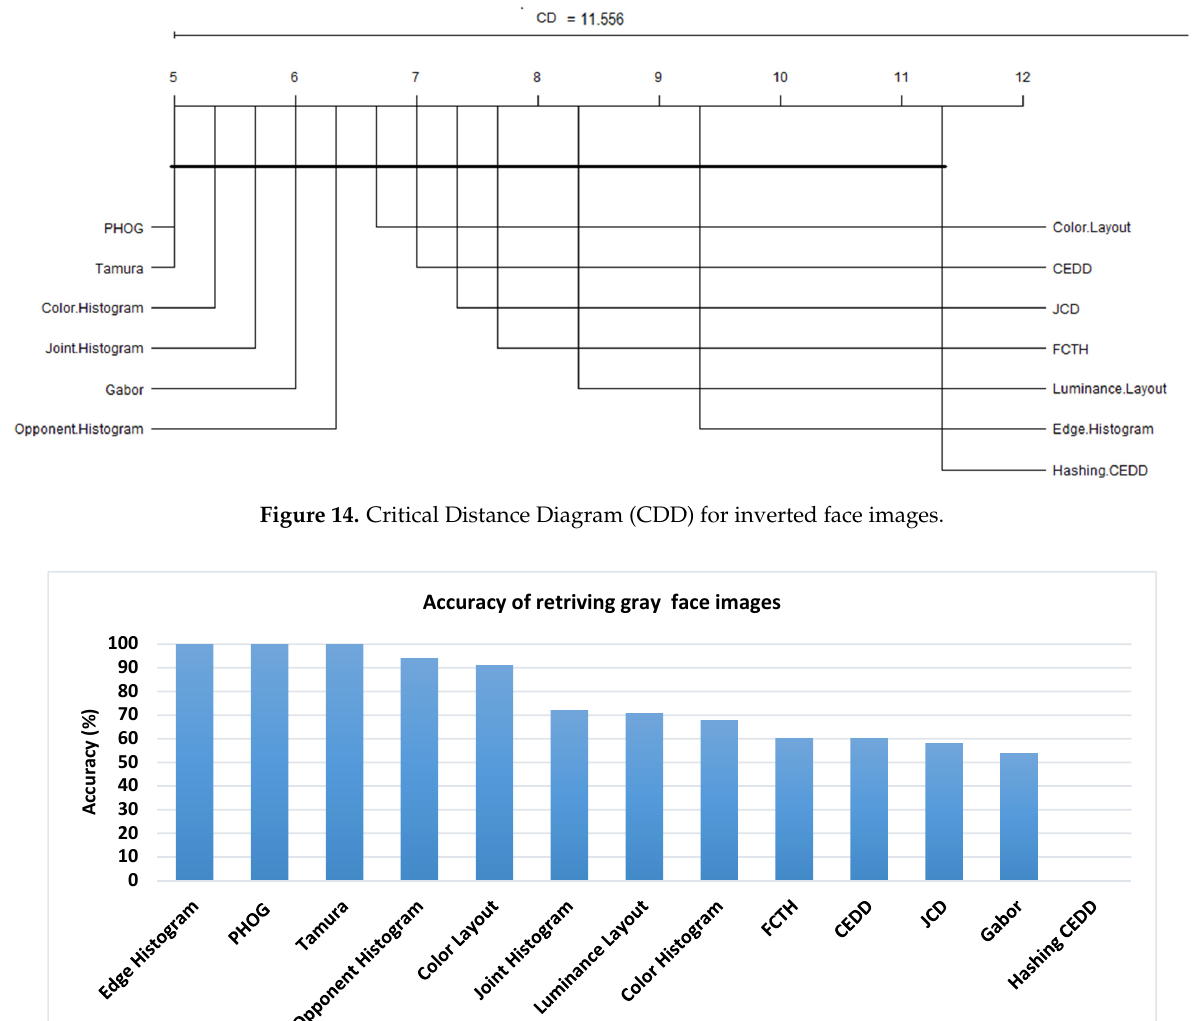
Figure 15. Average accuracy of retrieving grayscale face images.